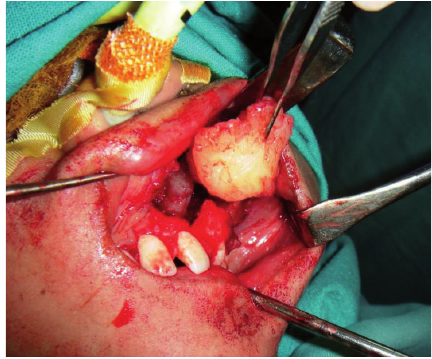
Figure 6: Curettage and complete removal of the lesion.